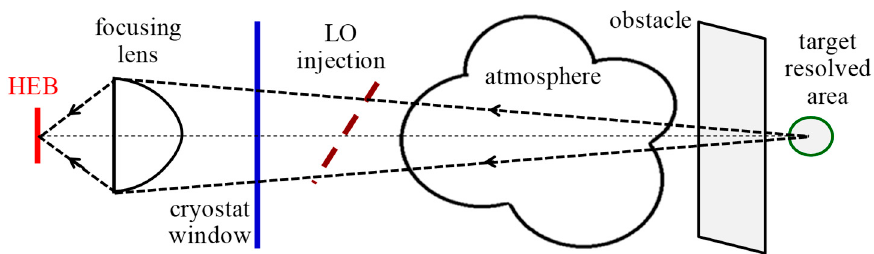
Figure 2. Simplified schematic for HEB standoff THz detection arrangement. The target resolved area is deduced from the Airy pattern at the HEB location (Equation (19)).